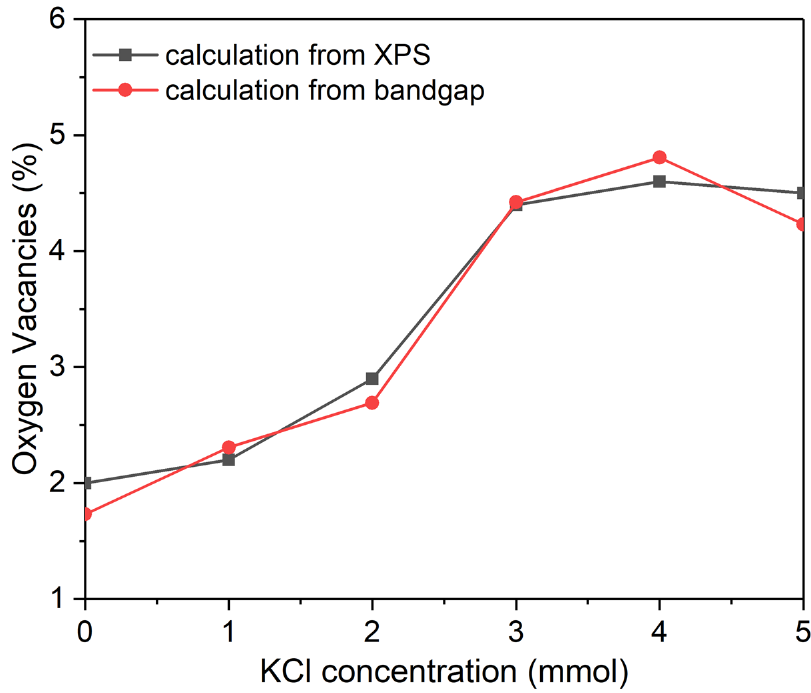
Figure 8. Relationship between oxygen vacancies (%) and KCl concentration, where the data of va- cancies are estimated from XPS spectra and bandgaps of KCl-BiVO 4